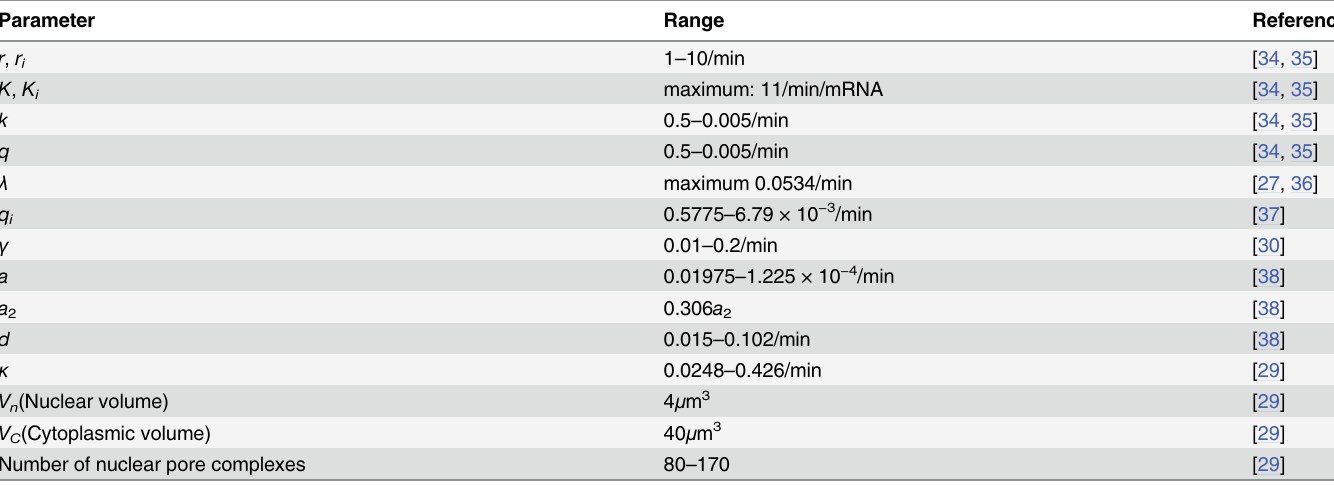
Table 1. Range of values for all